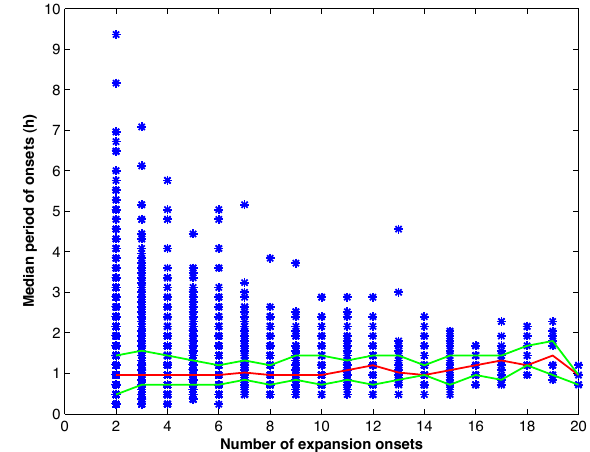
Fig. 6. Dependence of the period of consecutive substorm expansion onsets on the number of expansions in the event. Median periods are marked by the red line and 25% and 75% quartiles by green